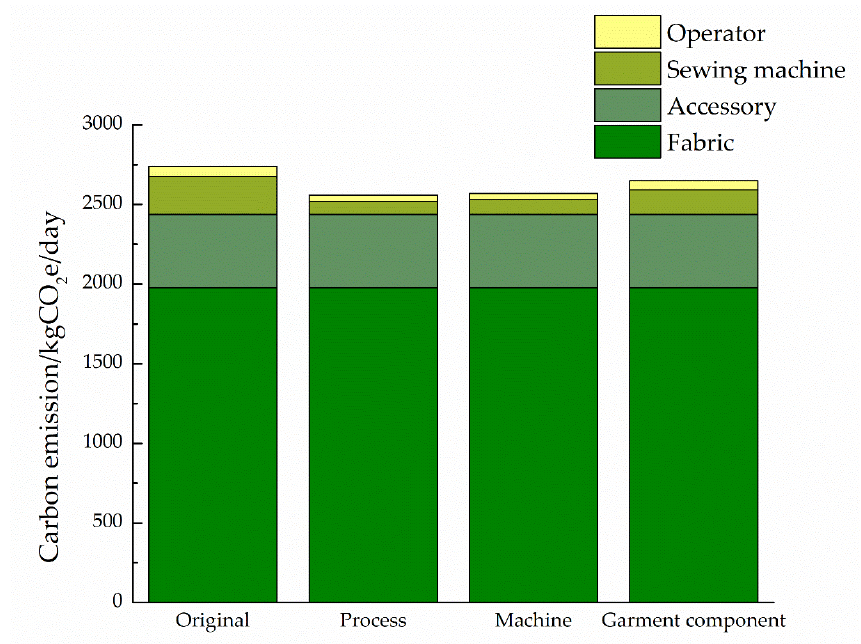
Figure 11. The total carbon emissions of different workstation layouts for the men’s shirt assembly line.